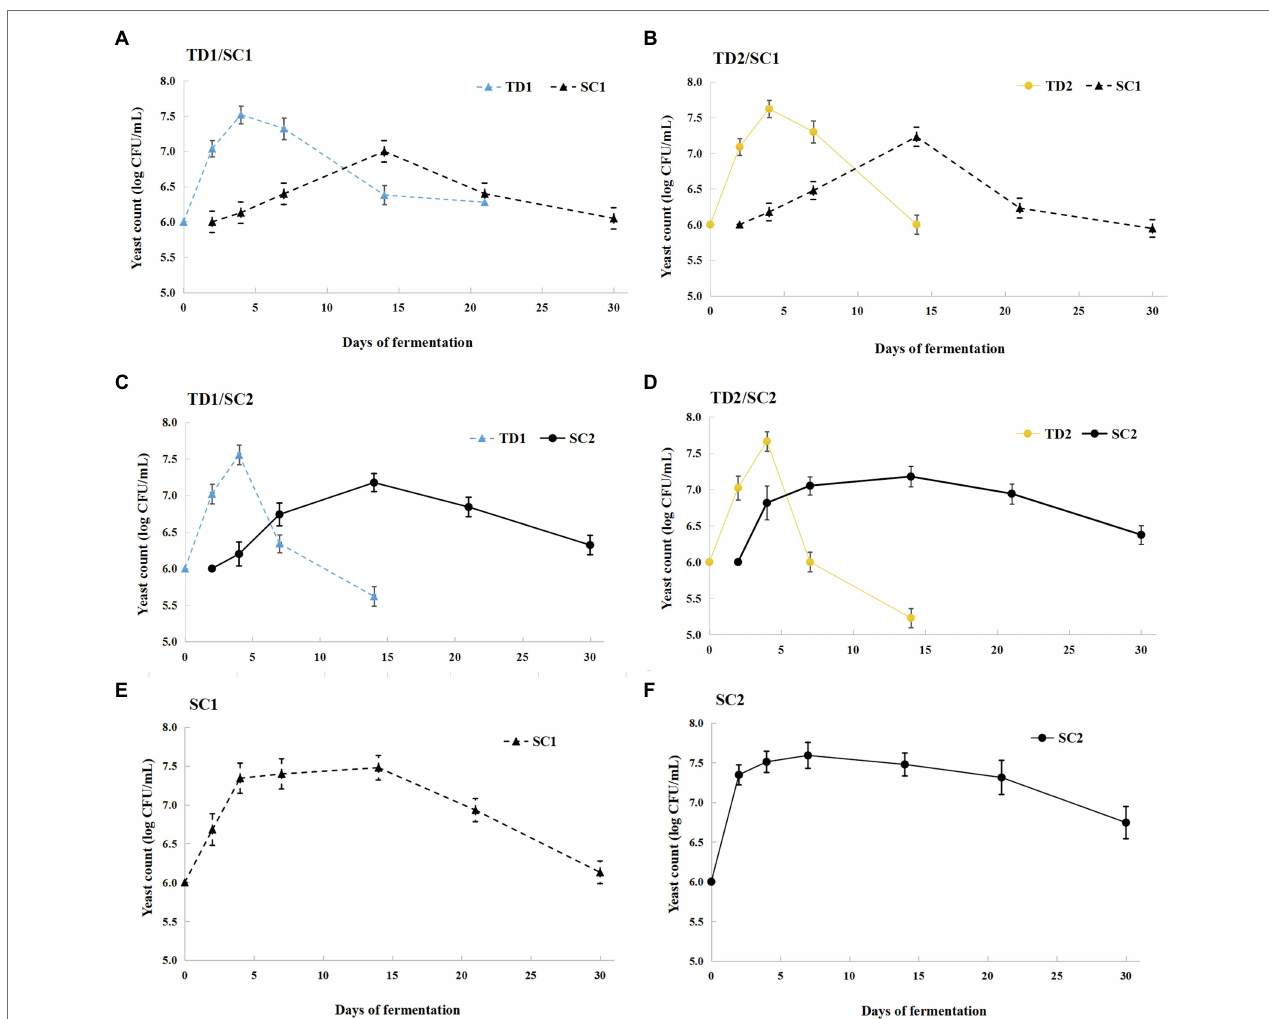
FIGURE 1 | Yeast population dynamic changes during pure and mixed culture fermentations. TD1/SC1, TD2/SC1, TD1/SC2, TD2/SC2 (A–D) : sequential inoculation with Torulaspora delbrueckii (TD1, TD2) followed by Saccharomyces cerevisiae (SC1, SC2) after 48 h; SC1 and SC2: single inoculation of S. cerevisiae SC1 (E) and SC2 (F) ,